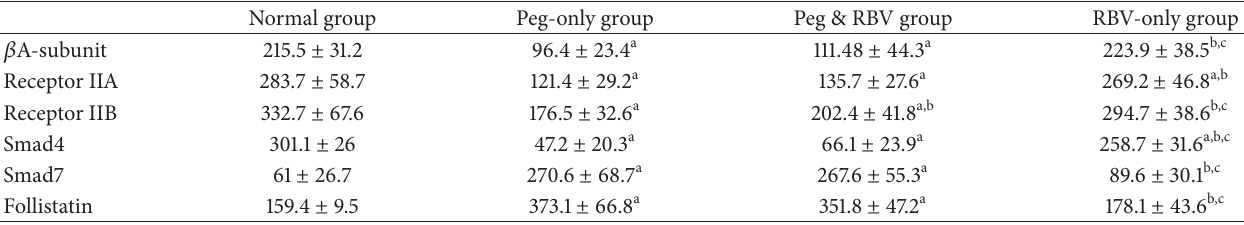
Table 3: Mean ± SD of immunohistochemistry scores for activin 𝛽 A-subunit, activin type receptor IIA and IIB, Smad4, Smad7, and follistatin proteins in liver